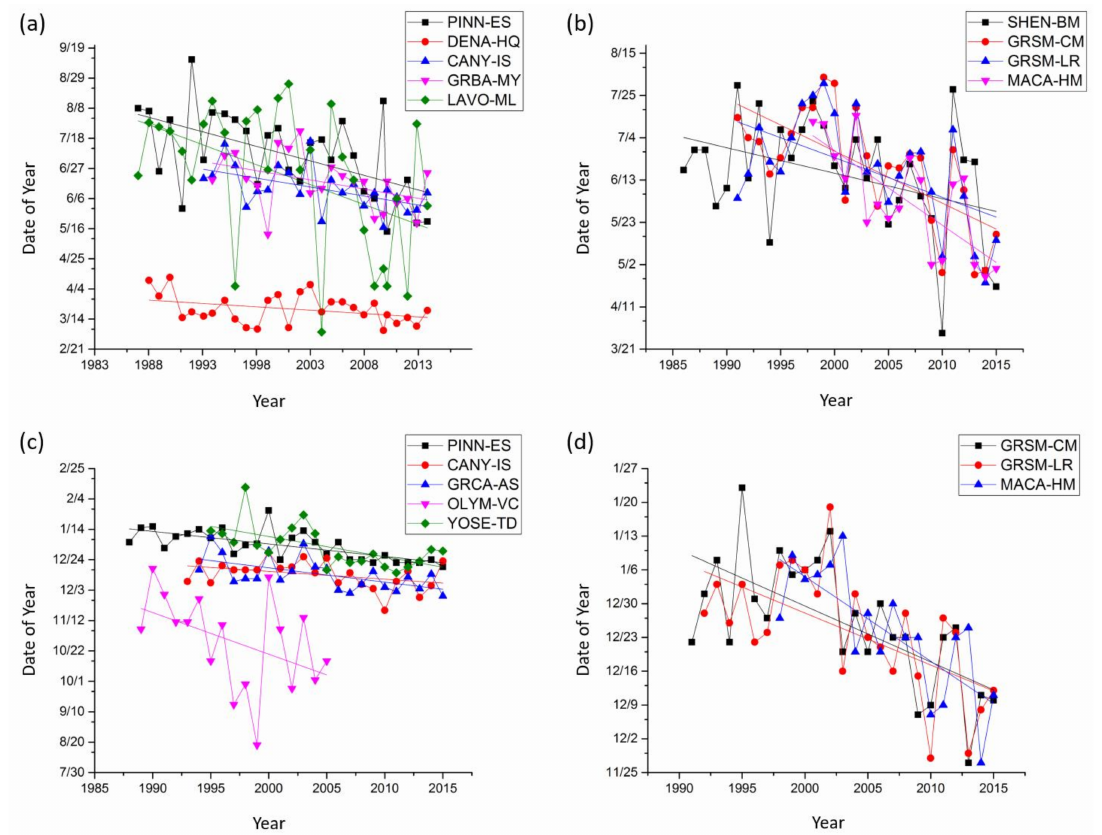
Figure 5. Significant shifts in the date of annual ozone peak values for the western ( a ) and eastern ( b ) sites. Significant shifts in the date of annual ozone minimum values for western ( c ) and eastern sites ( d